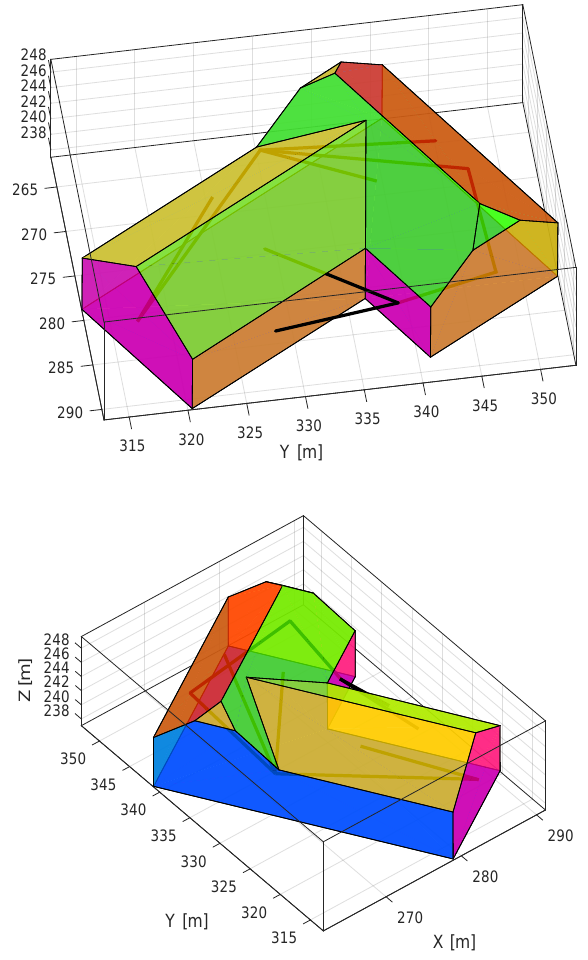
Figure 5. Two views of the boundary representation obtained by adjustment of the planes with 15 enforced orthogonality con- straints. As a result the ridge lines and the eaves are horizontal and the building’s outline features right